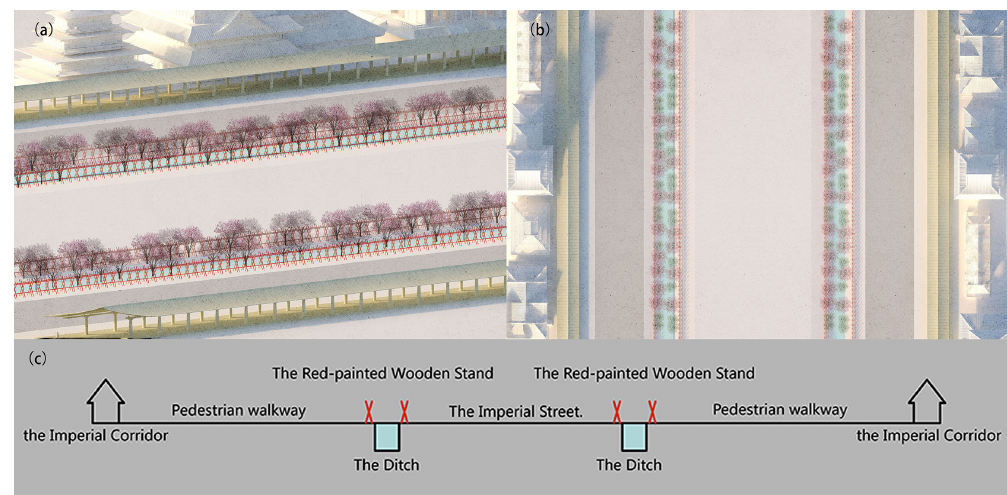
Figure 18. ( a ) Schematic diagram of the Imperial Street in Dongjing of the Northern Song Dynasty, ( b ) top view, ( c ) section.